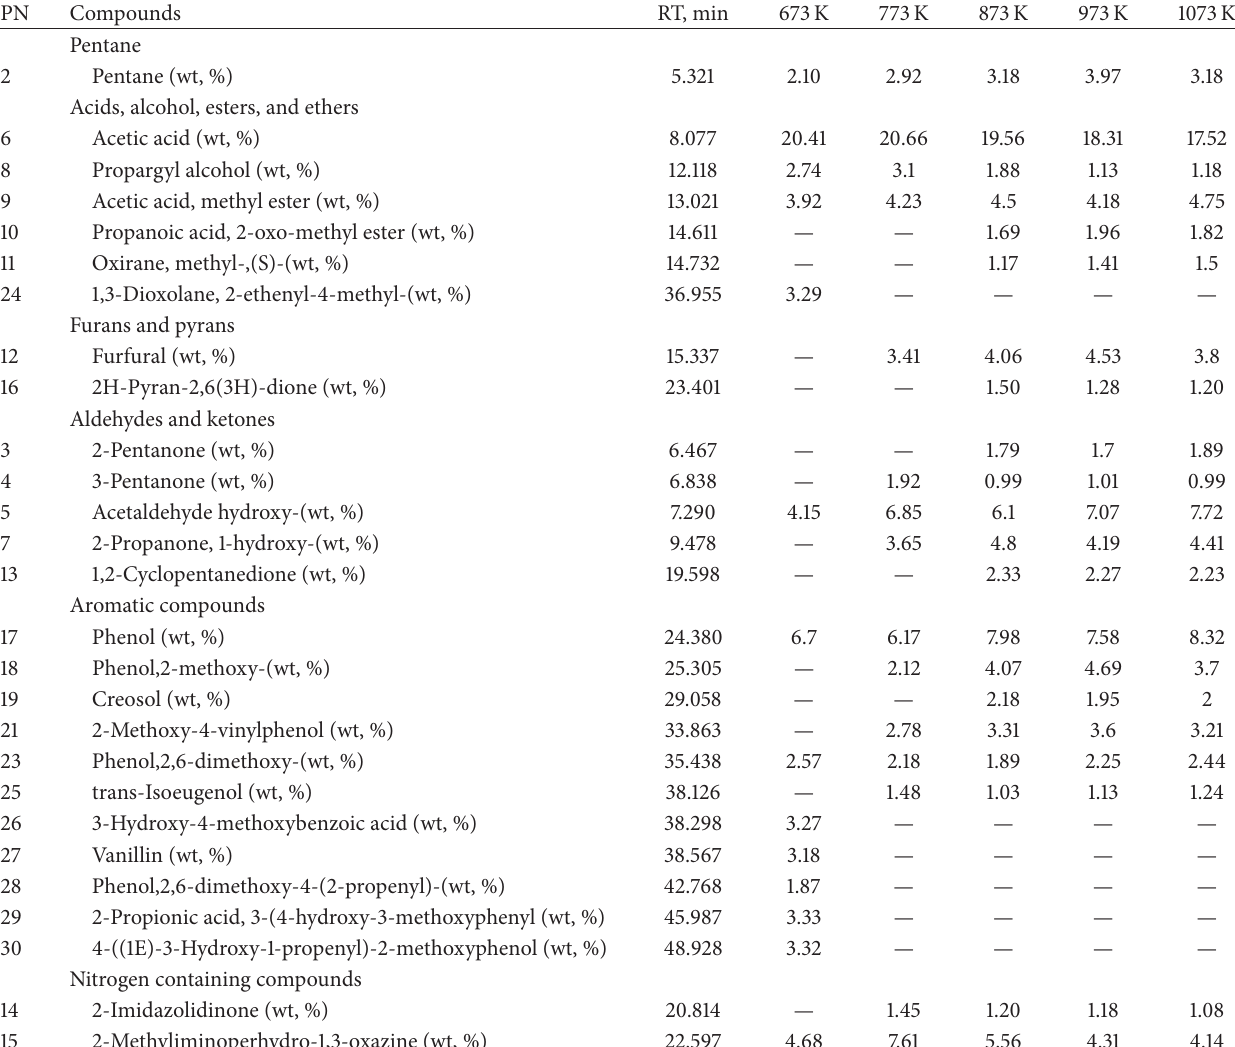
Table 3: Compounds produced during biomass